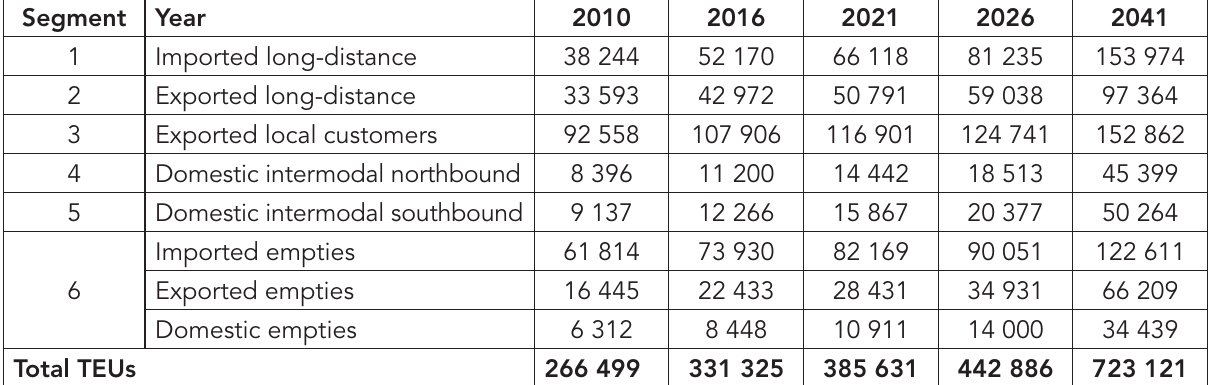
Table 3: Summary of base year and forecast segmented container volumes (TEUs) Segment